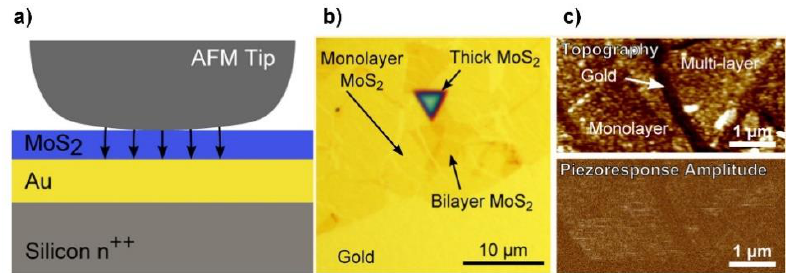
Figure 10. Flexoelectricity of the MoS 2 . ( a ) Schematic illustration of the measurement. Black arrows represent the electric field from the AFM tip. ( b ) Microscope image of MoS 2 layers on gold film. ( c ) ( top ) Topography and ( bottom ) piezoresponse amplitude of the MoS 2 layers on gold. Reproduced from [57] with permission from the American Chemical Society. Copyright 2017.